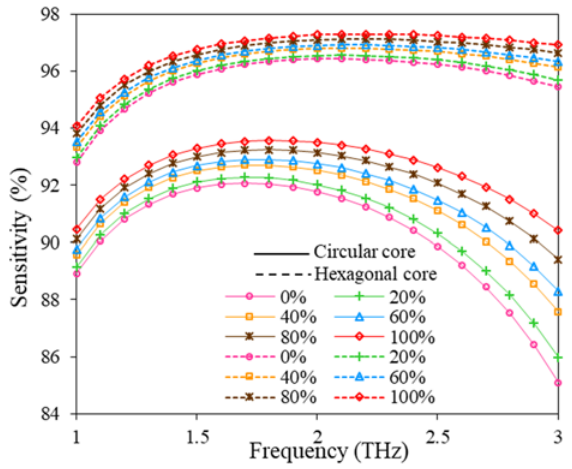
Figure 8. Field pattern of the x ‐ polarization core mode for ( a ) circular, and ( b ) hexagonal core at optimum design conditions.